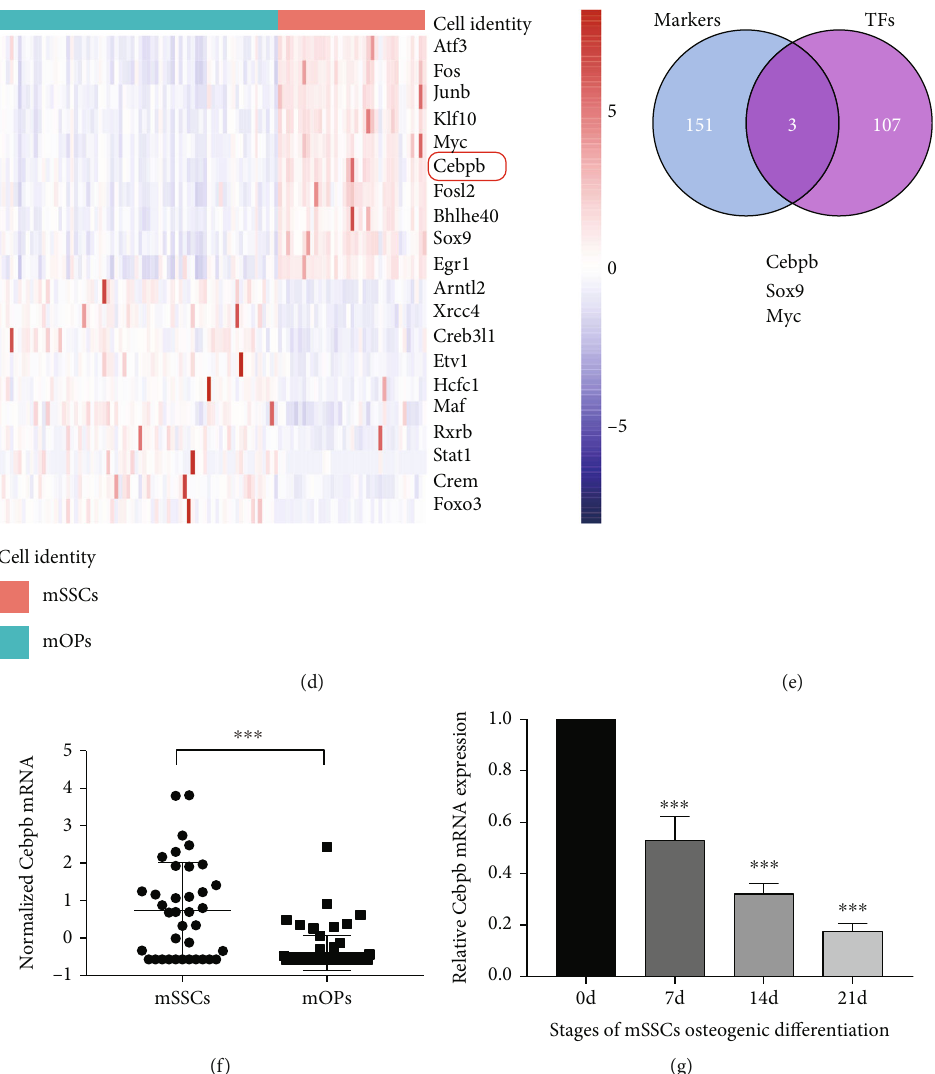
Figure 1: Signi fi cant TFs during di ff erent mSSC di ff erentiation stages. (a) t-SNE analyses on scRNA-seq data of mSSCs and mOPs. (b) A heat map shows the expression of cluster markers. (c) Top 10 biological processes from GO enrichment of signi fi cant markers. (d) A heat map shows the expression of signi fi cant TFs. (e) Venn diagram of signi fi cant markers and signi fi cant TFs. (f) Comparison of normalized Cebpb expression in mSSCs and mOPs in the GSE142873 dataset. ∗∗∗ p < 0 : 001 . (g) The relative expression of Cebpb mRNA on day 0, day 7, day 14, and day 21 of mSSC osteogenic di ff erentiation detected by qPCR. ∗∗∗ p < 0 : 001 compared with 0 d. Abbreviations: mOPs: mouse osteoprogenitors; mSSCs: mouse skeletal stem cells; TFs: transcription